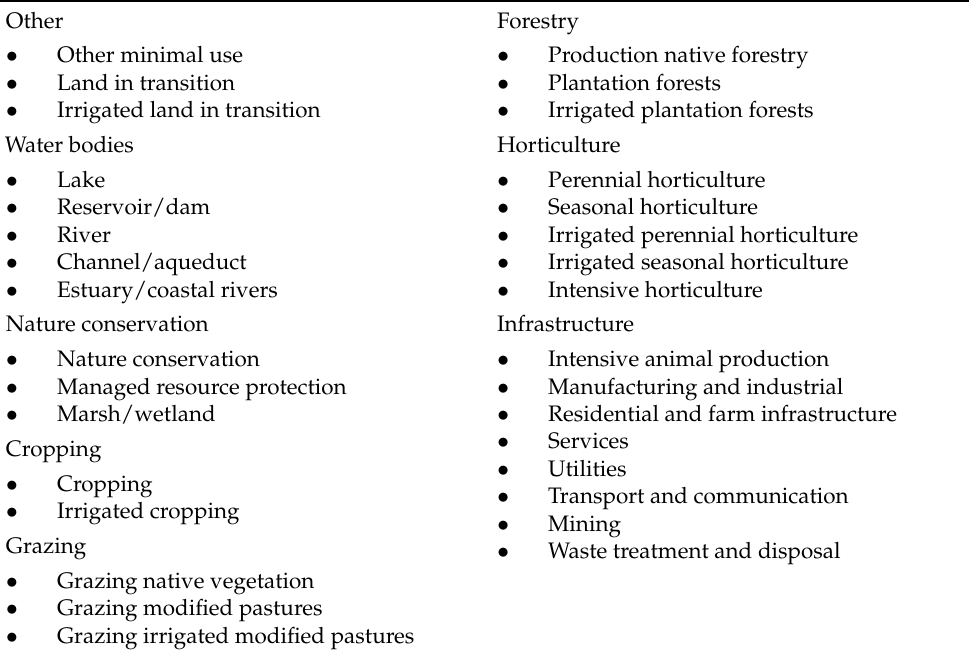
Table A3. All thirty-one land use types present in the NSW Landuse 2017 v1.2 dataset; the eight reclassified land use type categories are also provided in italics above the land use types that were used to create